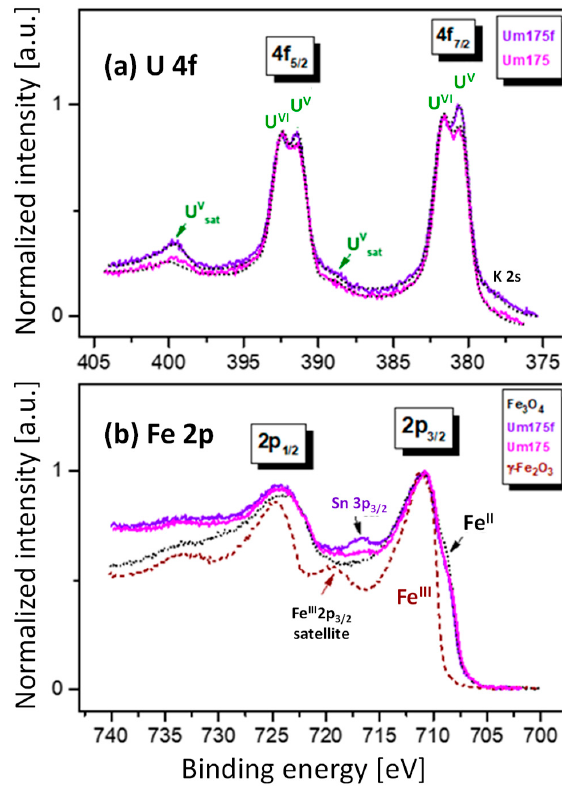
Figure 9. XP spectra of U(VI) reacted magnetite - ( a ) U 4 f 7/2,5/2 doublet of Um175f (blue) and Um175 (violet); ( b ) Fe 2 p 3/2,1/2 doublet of stoichiometric Fe 3 O 4 (dots), Um175f, Um175 and γ -Fe 2 O 3 (dashes).